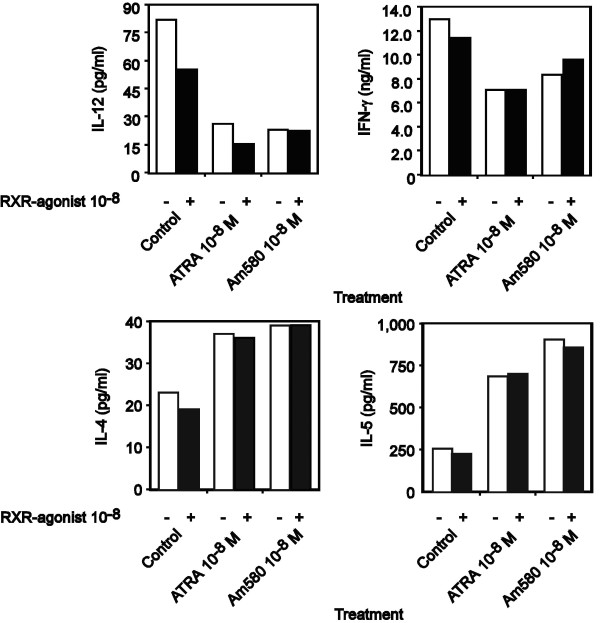
The effects of ATRA on Th1 and Th2 cytokine production are primarily mediated through RAR-α with minimal involvement of liganded RXRs. IL-12p70 and IFN-γ (Panel A) and IL-4 and IL-5 (Panel B) proteins were quantitated by ELISA in supernatants of 48 h, anti-CD3,-activated PBMC treated in the absence or presence of EtOH, ATRA (10-8 M), or the RAR-α agonist, AM580 (10-8 M) and in the presence or absence of EtOH (□) or the RXR agonist (10-8 M, ■). The above data are representative of the results from two different donors examined.